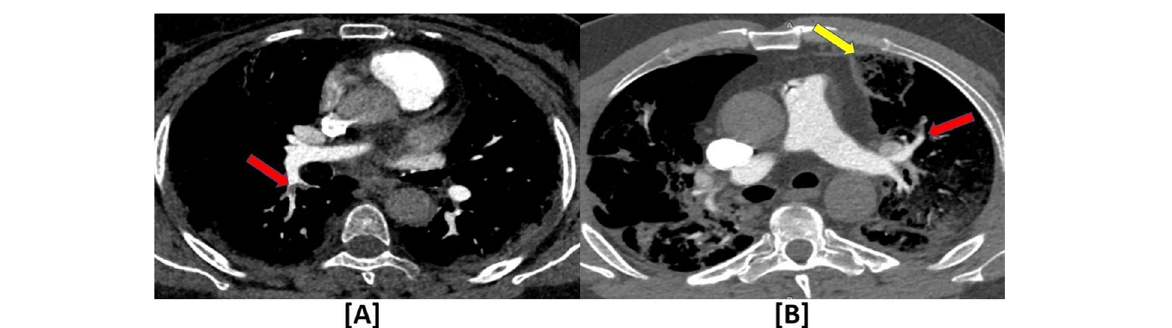
Fig. 2 COVID-19 induced acute pulmonary embolism and pulmonary infarction. a A 66-year-old female patient with acute pulmonary embolism (PE) ; axial mediastinal window CTPA revealed a small branching filling defect at the right lower lobar pulmonary artery (red arrow). b A 52-year- old male patient with acute pulmonary embolism (PE) and pulmonary infarction (PI) ; axial mediastinal window CTPA revealed a small filling defect at the anterior segmental branch of the left upper lobar pulmonary artery (red arrow) and sub-pleural wedge-shaped lesion showing bubbly air densities (yellow